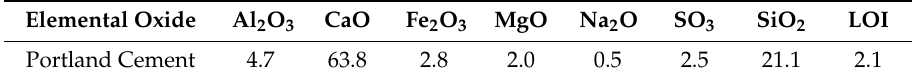
Table 1. Bulk oxide composition (wt %) and loss of ignitionat 1000 ◦ C of the Portland cement. Elemental Oxide